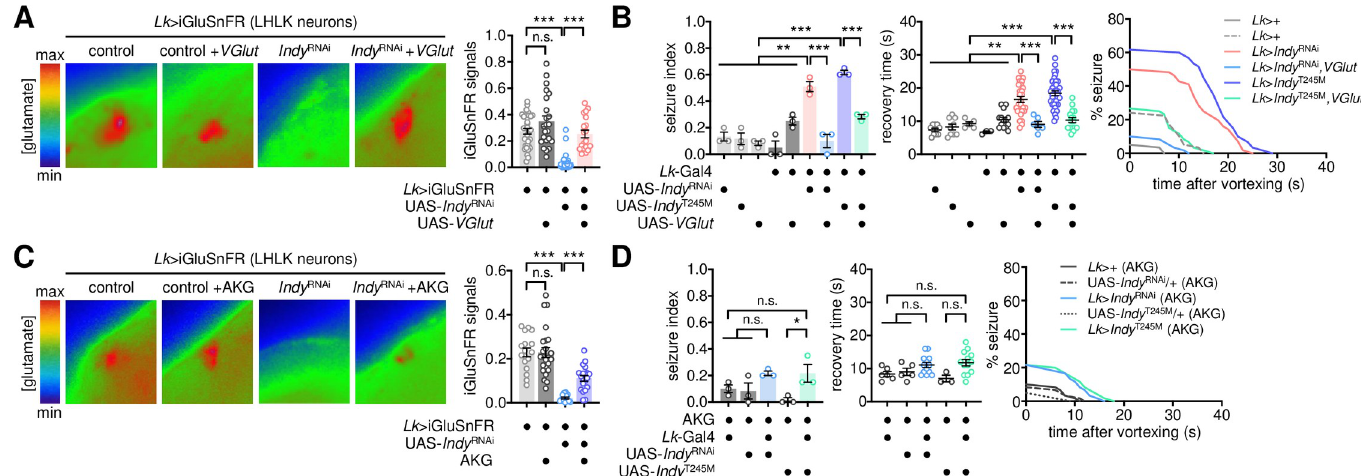
Fig 5. LK neurons suppress seizures via metabolic control of glutamate transmission. (A) Overexpression of wild-type VGLUT rescues low glutamate levels in INDY- depleted LHLK neurons. The fluorescent glutamate sensor, iGluSnFR, was co-expressed with Indy RNAi and wild-type VGLUT transgenes in LK neurons. Fluorescence images of LHLK neurons in dissected brains were recorded using photoactivated localization microscopy and analyzed using ZEN software. Relative fluorescence was calculated by normalizing to backgrounds and was averaged for each genotype (n = 19–38). A significant Indy x VGlut interaction effect on the iGluSnFR signal ( P < 0.0001) was detected by Aligned ranks transformation ANOVA. Error bars indicate SEM. n.s., not significant; ��� P < 0.001, as determined by Wilcoxon rank sum test. (B) Overexpression of wild-type VGLUT suppresses BSS caused by the loss of Indy function in LK neurons. Quantitative analyses of BSS in individual flies were performed as described in Fig 1. Data represent means ± SEM (seizure index, n = 56–60 flies in 3 independent experiments; recovery time, n = 3–37 flies). �� P < 0.01, ��� P < 0.001, as determined by one-way ANOVA with Holm-Sidak’s multiple comparisons test. (C) Oral administration of AKG rescues low glutamate levels in INDY- depleted LHLK neurons. Transgenic flies were fed control or AKG-containing food (20 mM) for 3 d before live-brain imaging. A significant Indy x AKG interaction effect on the iGluSnFR signal ( P = 0.0014) was detected by Aligned ranks transformation ANOVA. Data represent means ± SEM (n = 16–24). n.s., not significant; ��� P < 0.001, as determined by Wilcoxon rank sum test. (D) Oral administration of AKG suppresses BSS caused by the loss of Indy function in LK neurons. Data represent means ± SEM (seizure index, n = 60 flies in 3 independent experiments; recovery time, n = 3–13 flies). n.s., not significant; � P < 0.05, as determined by one-way ANOVA with Holm-Sidak’s multiple comparisons test.